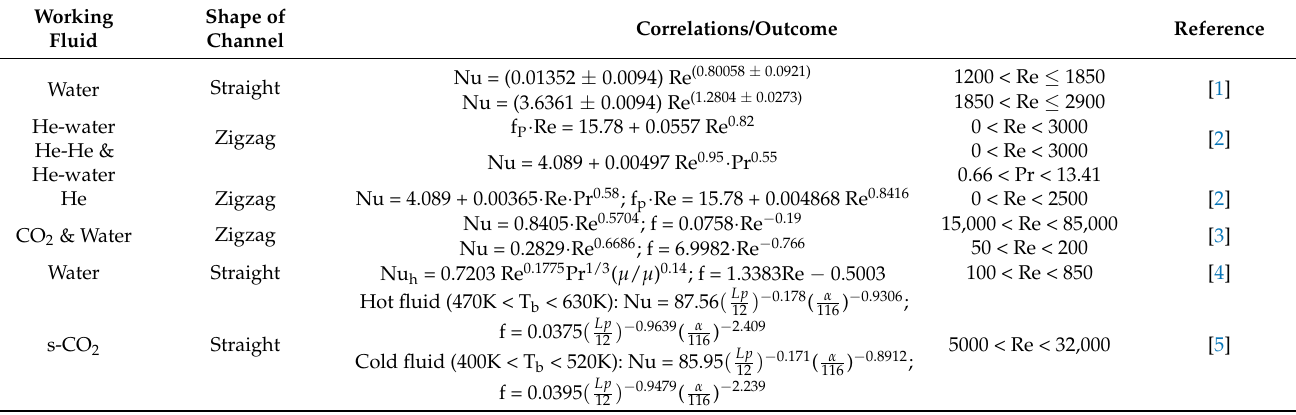
Correlations/Outcome